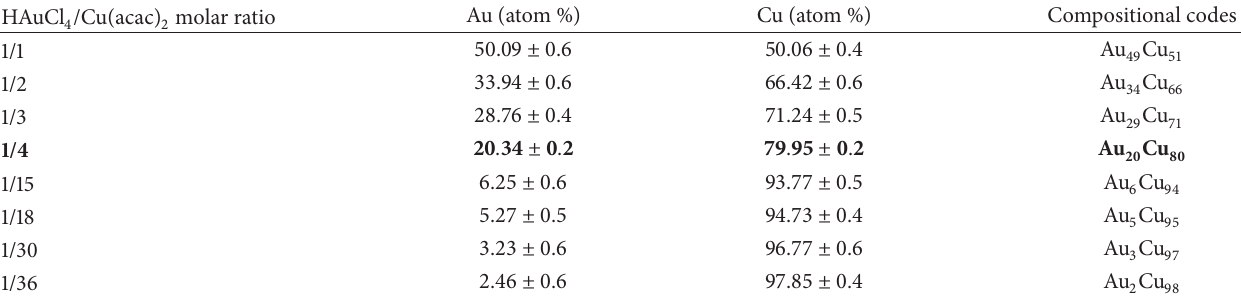
Table 1: Composition of synthesized AuCu alloys and their